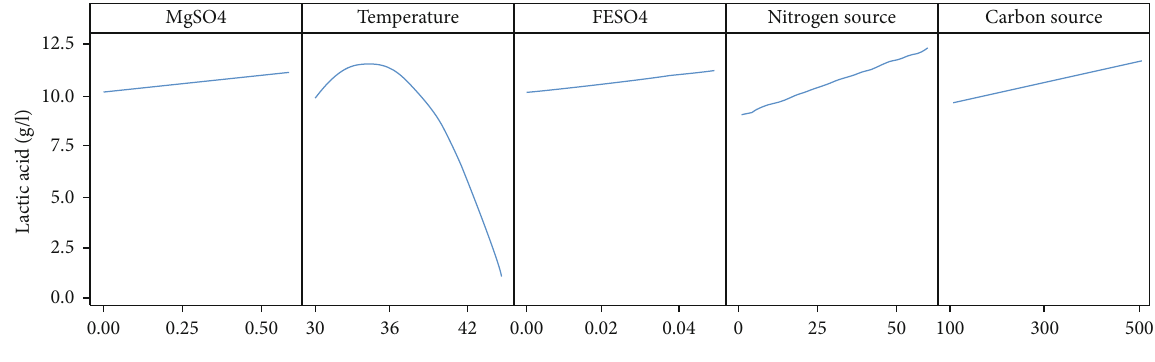
Figure 3: E ff ects of factors on LA production. Table 7: p values, contribution of factors (CF) coe ffi cient of determination ( R 2 ), absolute average deviation (AAD), and bias factor (Bf) for optimized production of LA following CCD